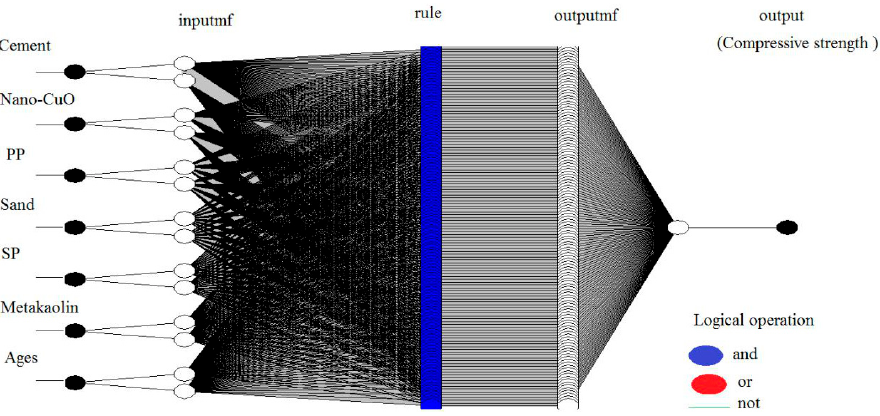
Figure 3. ANFIS structure for prediction. Table 5. Adaptive neuro-fuzzy inference system (ANFIS) and Primal Estimated sub-GrAdient Solver for SVM (Pegasos) results. ANFIS